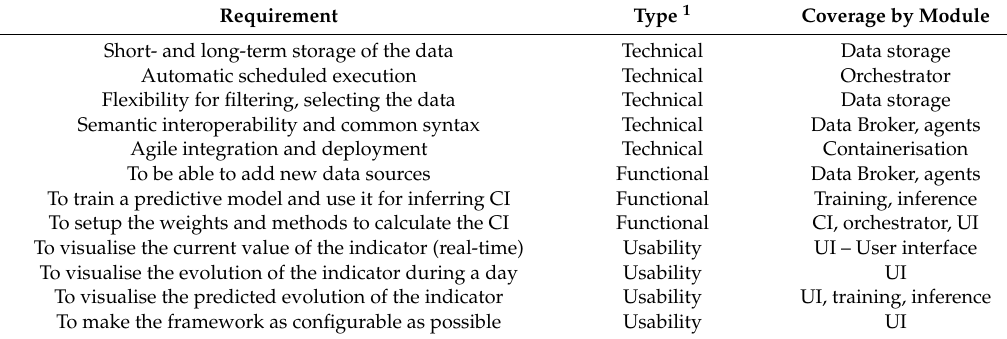
Table 1. Technical and functional requirements for designed the IoT framework of this